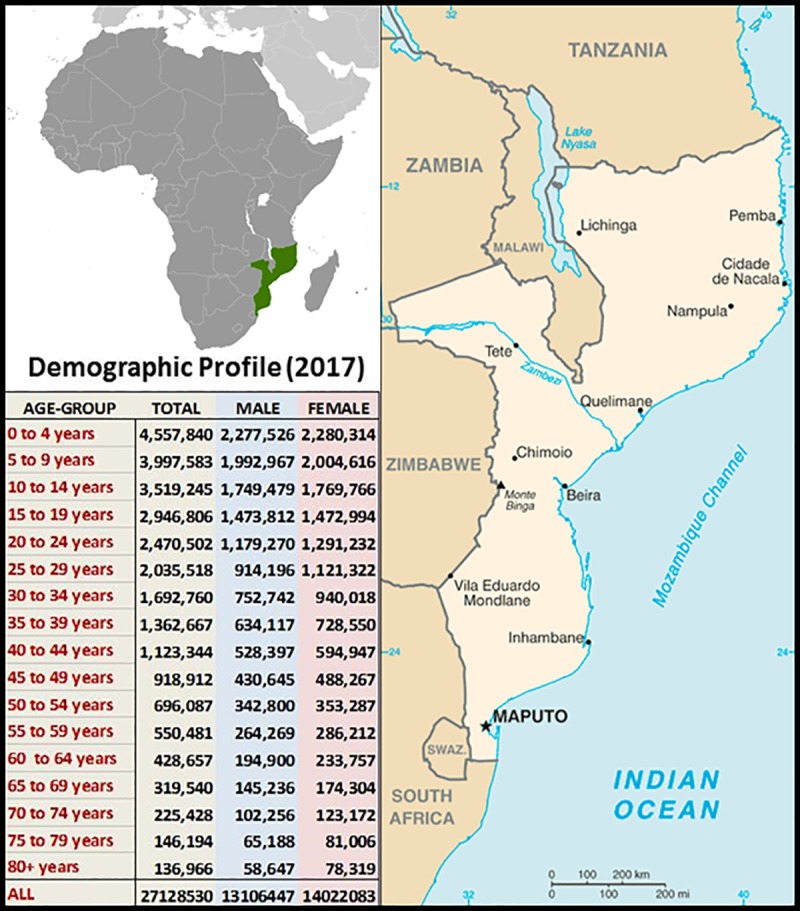
Geographic and demographic profile of Mozambique.Demographic profiling data (table inset) were sourced from http://www.ine.gov.mz/estatisticas/ (Accessed February 2019) and the public domain maps from https://www.drivingdirectionsandmaps.com/mozambique-google-map/ (Accessed May 2019).